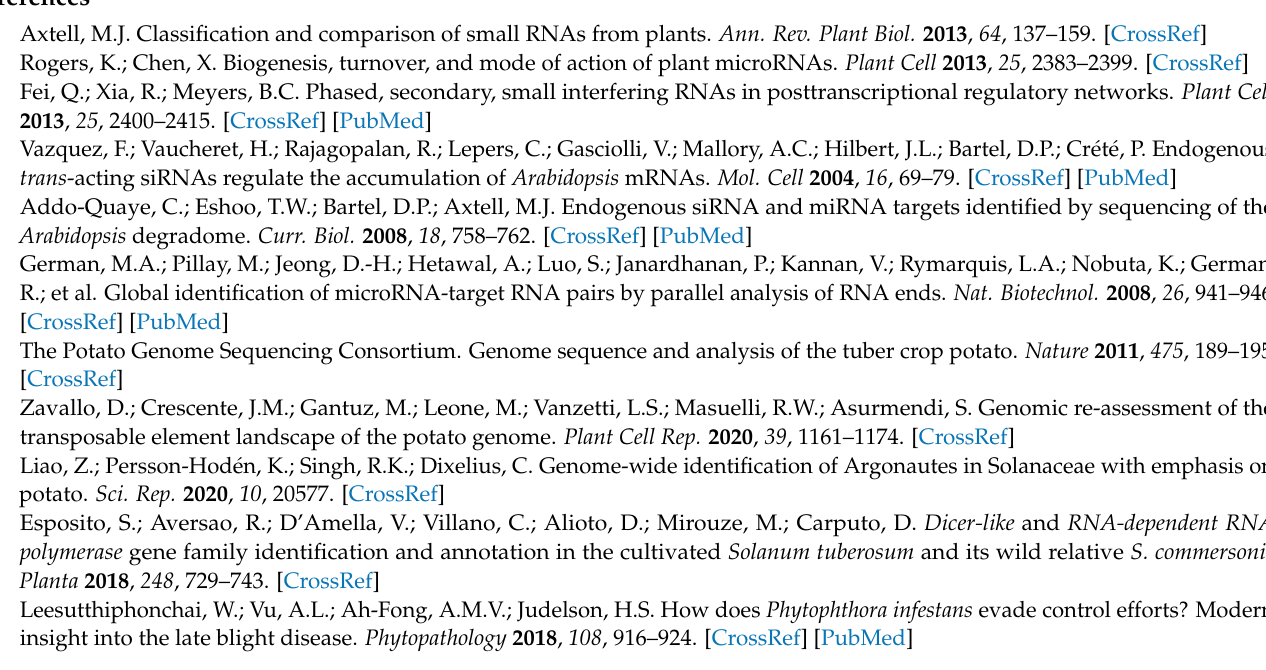
in all 15 datasets included in the analysis. Table S2. Comparison datasets (CDs) were created by comparison between infection datasets and non-infection datasets. Table S3. Summary of final model visualizing the shape and number of parameters (param #) for each layer of the model. Table S4. Tunable parameters in the Bayesian optimization. Table S5. miRNA–mRNA cleavage data from earlier studies detected in the present analysis. Table S6. Potato miRNA families. Table S7. Precursor summary of sRNA targeting in potato and P. infestans . Table S8. Number of PHAS loci per nucleotide length of each individual locus. Table S9. Target genes with increased NFA in the R gene dataset. Table S10. Target genes with decreased NFA in the R gene dataset. Dataset 1. Precursor and target site information of endo- and exogenous sRNAs in the NFA-increased datasets. Dataset 2. Precursor and target site information of endo- and exogenous sRNAs in the NFA-decreased